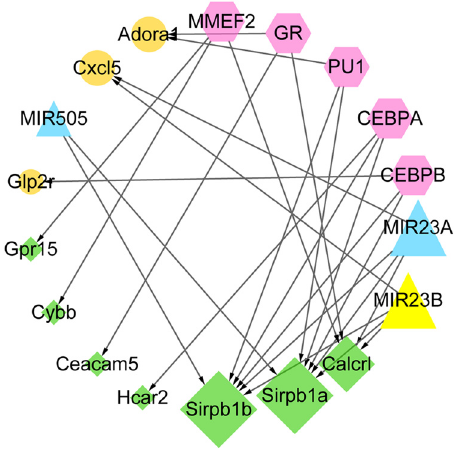
Figure 5: Analysis of TF - miRNA - target gene regulatory network. The yellow circle represents the upregulated gene, the green prismatic represents downregulated gene. The red hexagon represents microRNA ( miRNA ) , the blue triangle represents TF, and the arrow connecting line indicates the direction of regulation.